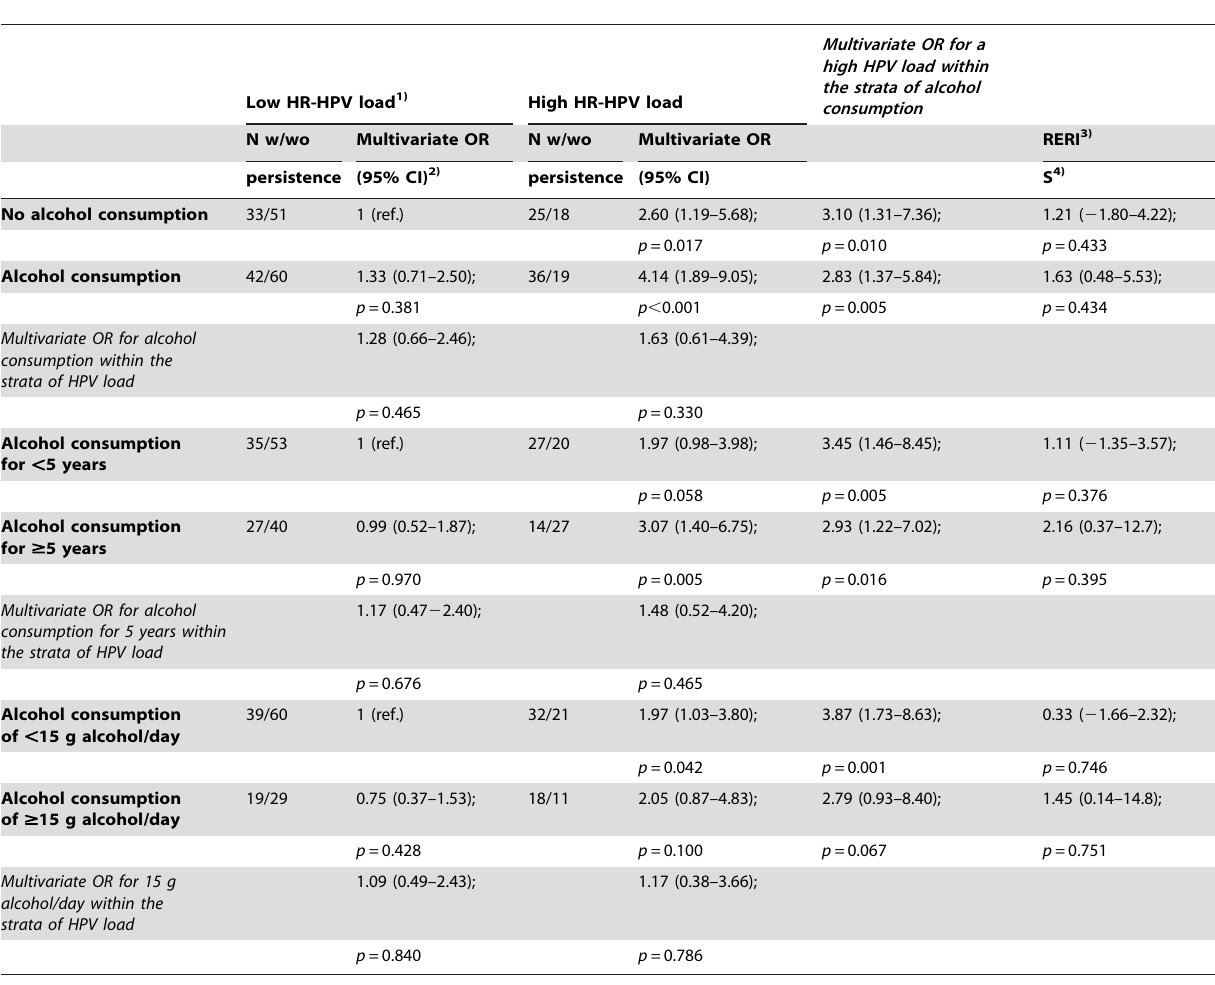
Table 4. Interaction between a high HR-HPV load and alcohol consumption on the risk of 1-year HR-HPV